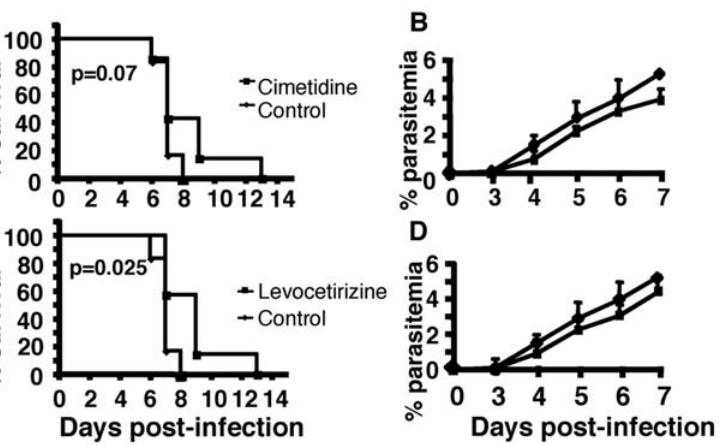
Figure 8. Effect of treatment with histamine receptor inhibitors on ongoing Pb ANKA infection. Panels A and C indicate survival rates of C57BL/6 infected with Pb ANKA 5 days prior daily treatments until the end of the experiment with either Cimetidine or Levocetirizine. These data are from one experiment using 7 mice per group. Significant differences in mortality/survival were observed between drug-treated and untreated mice using the log-rank test. Parasitemia (B, and D) were not significant.